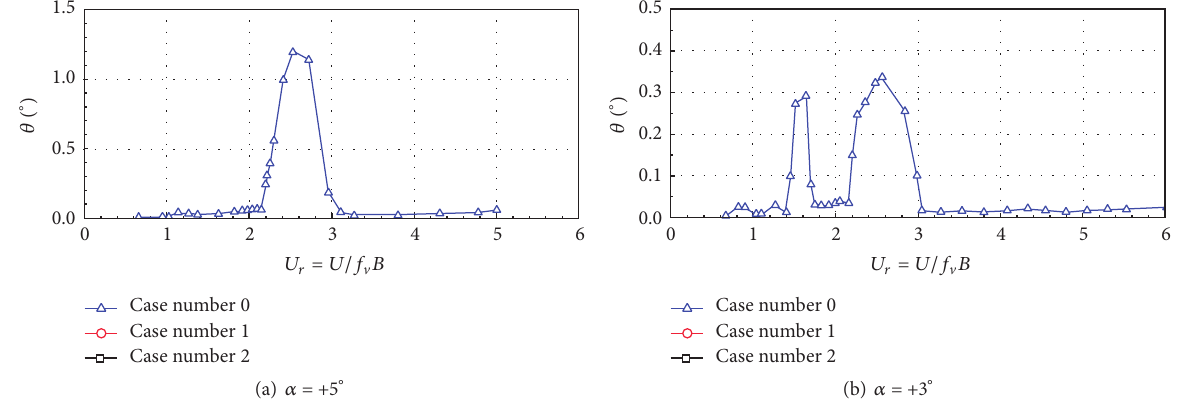
Figure 4: RMS of torsional displacement of Case #0